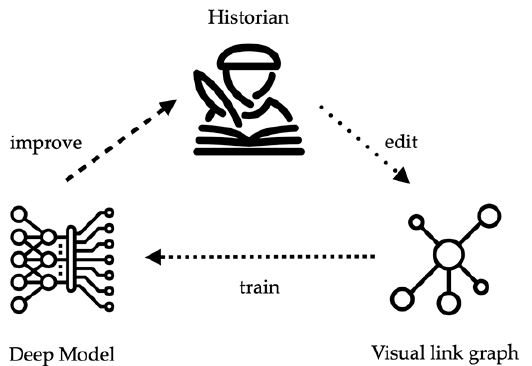
Figure 13. The loop of the annotation system.